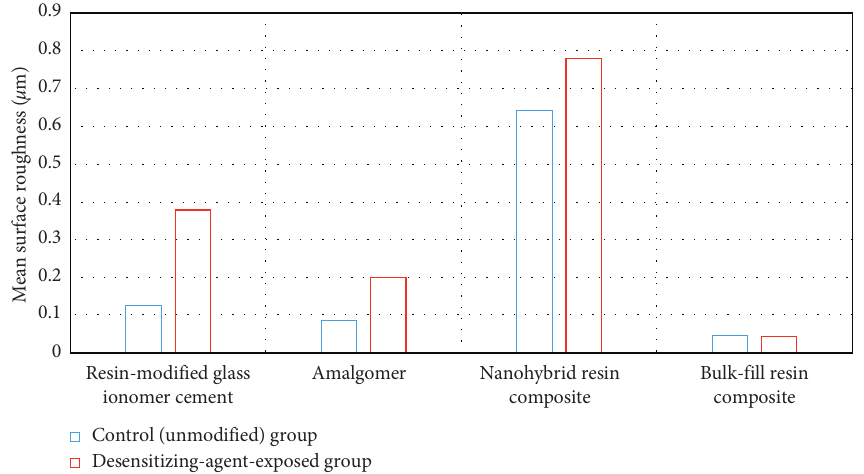
Figure 3: Graphical presentation of Student’s t -test results of the surface roughness ( μ m) of the tested materials.